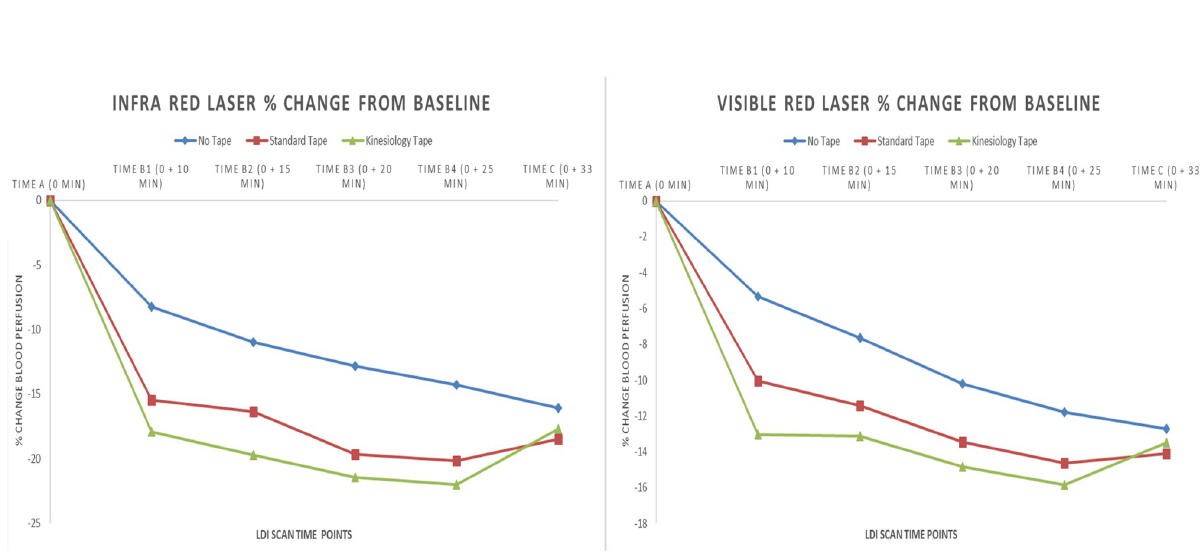
Fig 5. Figure showing percentage change of blood perfusion from baseline measured by infrared (left) and visible-red laser (right). Scan time point A corresponds to pre-intervention, B1 corresponds to during-intervention-5-mins, B2 corresponds to during-intervention-10-mins, B3 corresponds to during-intervention-15-mins, B4 corresponds to during-intervention-20-mins, C corresponds to post-intervention.